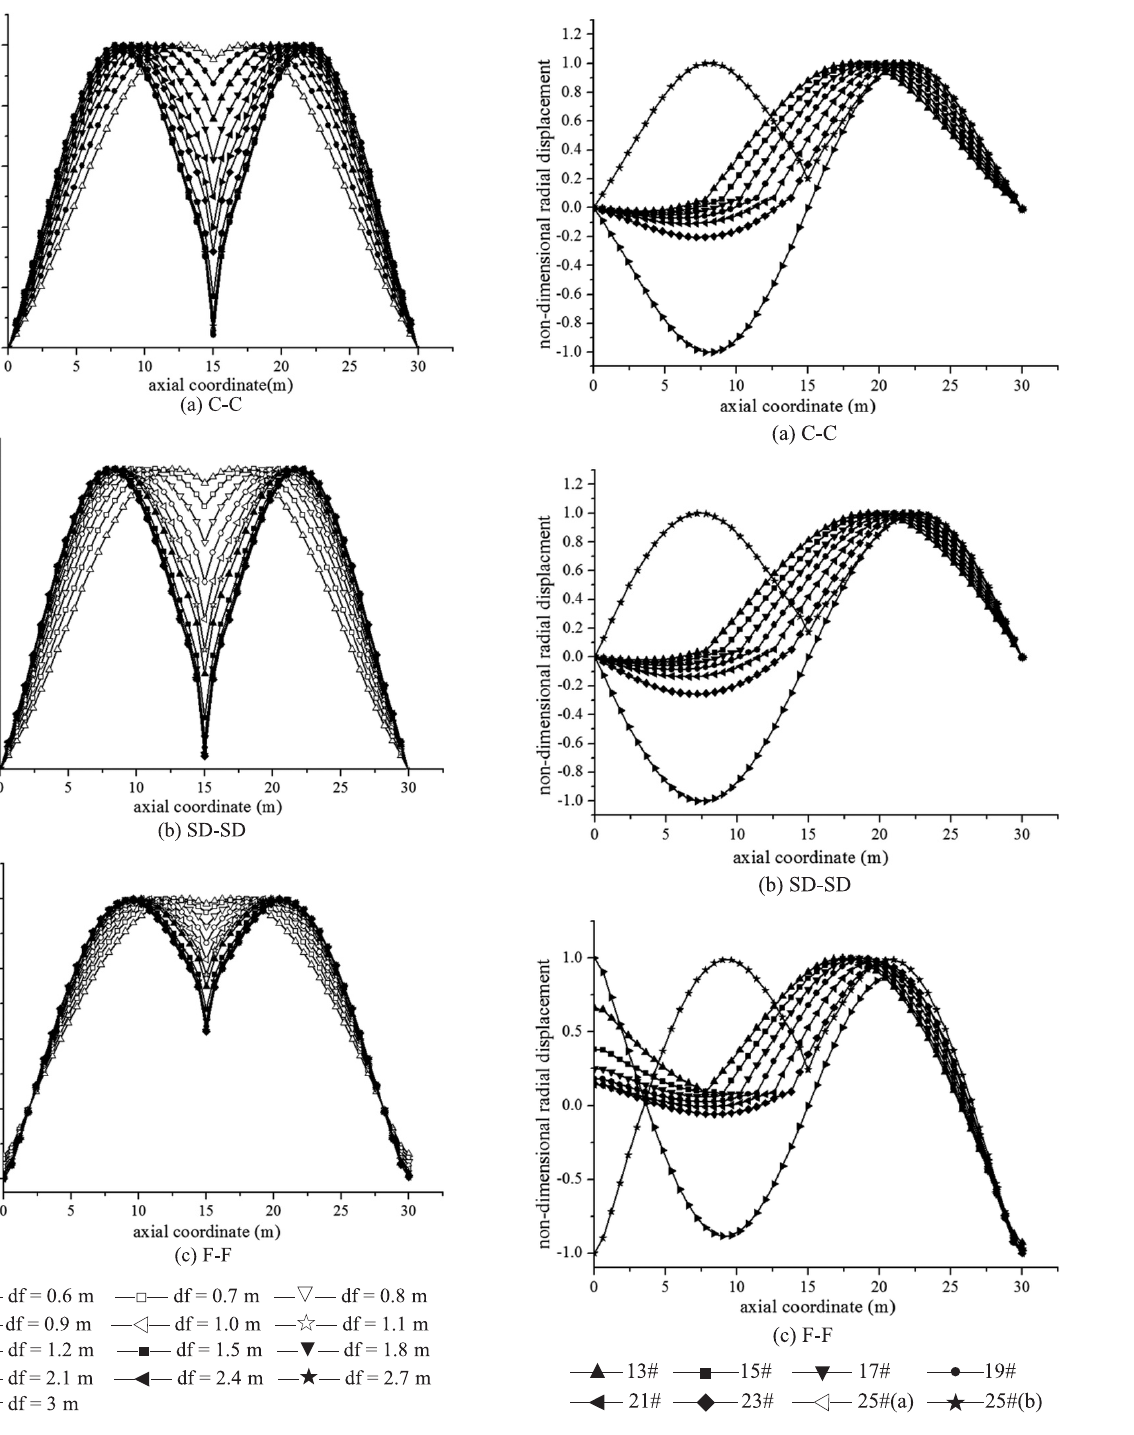
Fig. 13. Variation of “cabin subdivision vibration mode” shapes of n = 3, m = 2(b) with the depth of the intermediate frame rib for bf = 0.018 m.